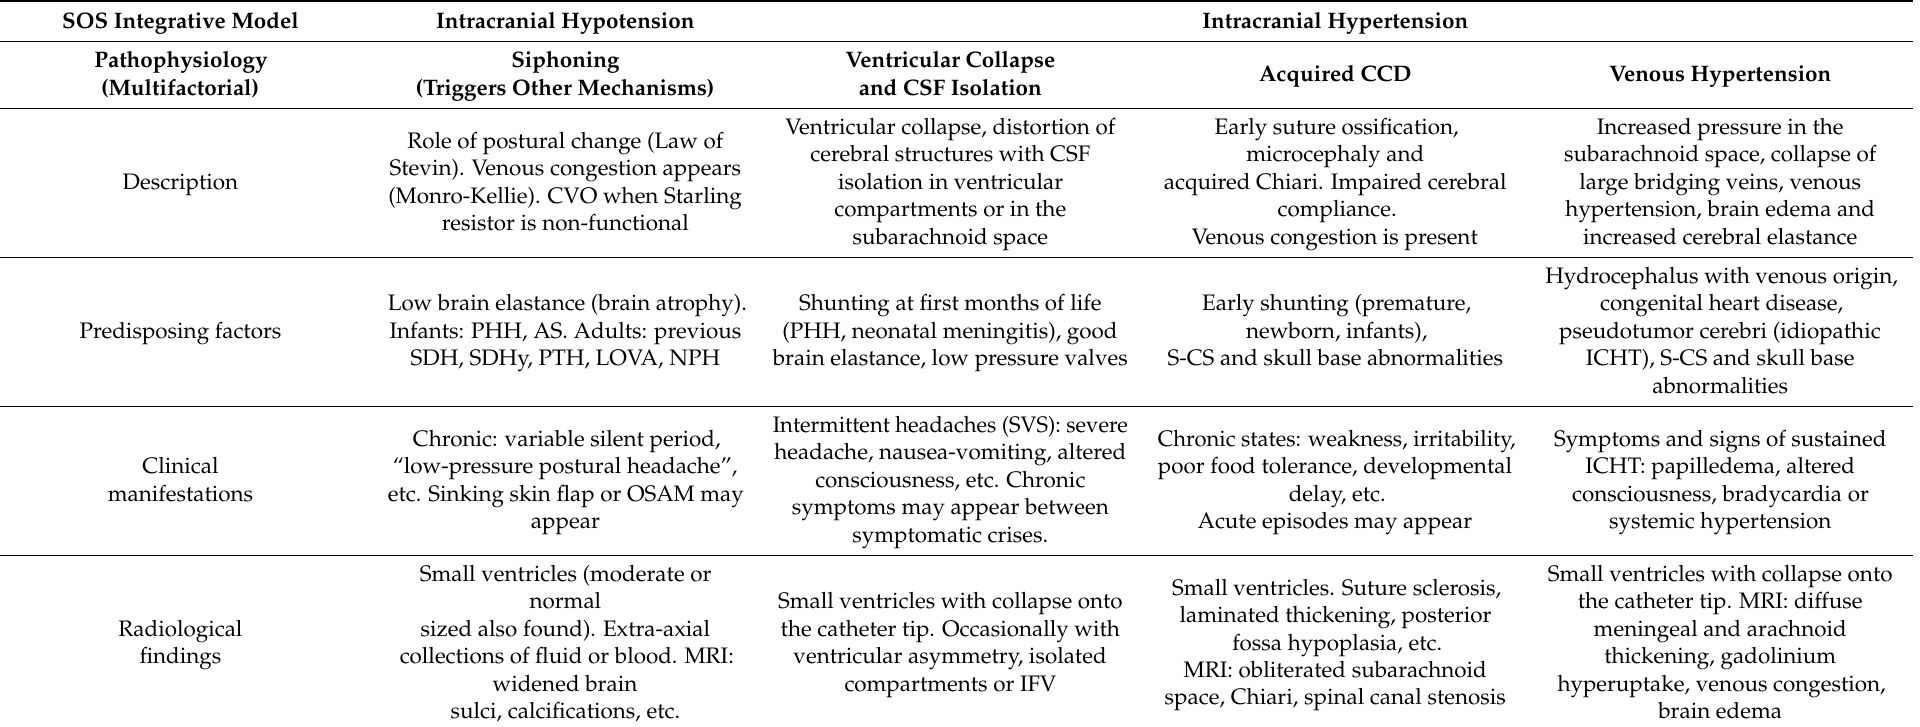
Table 1. Integrative Model for